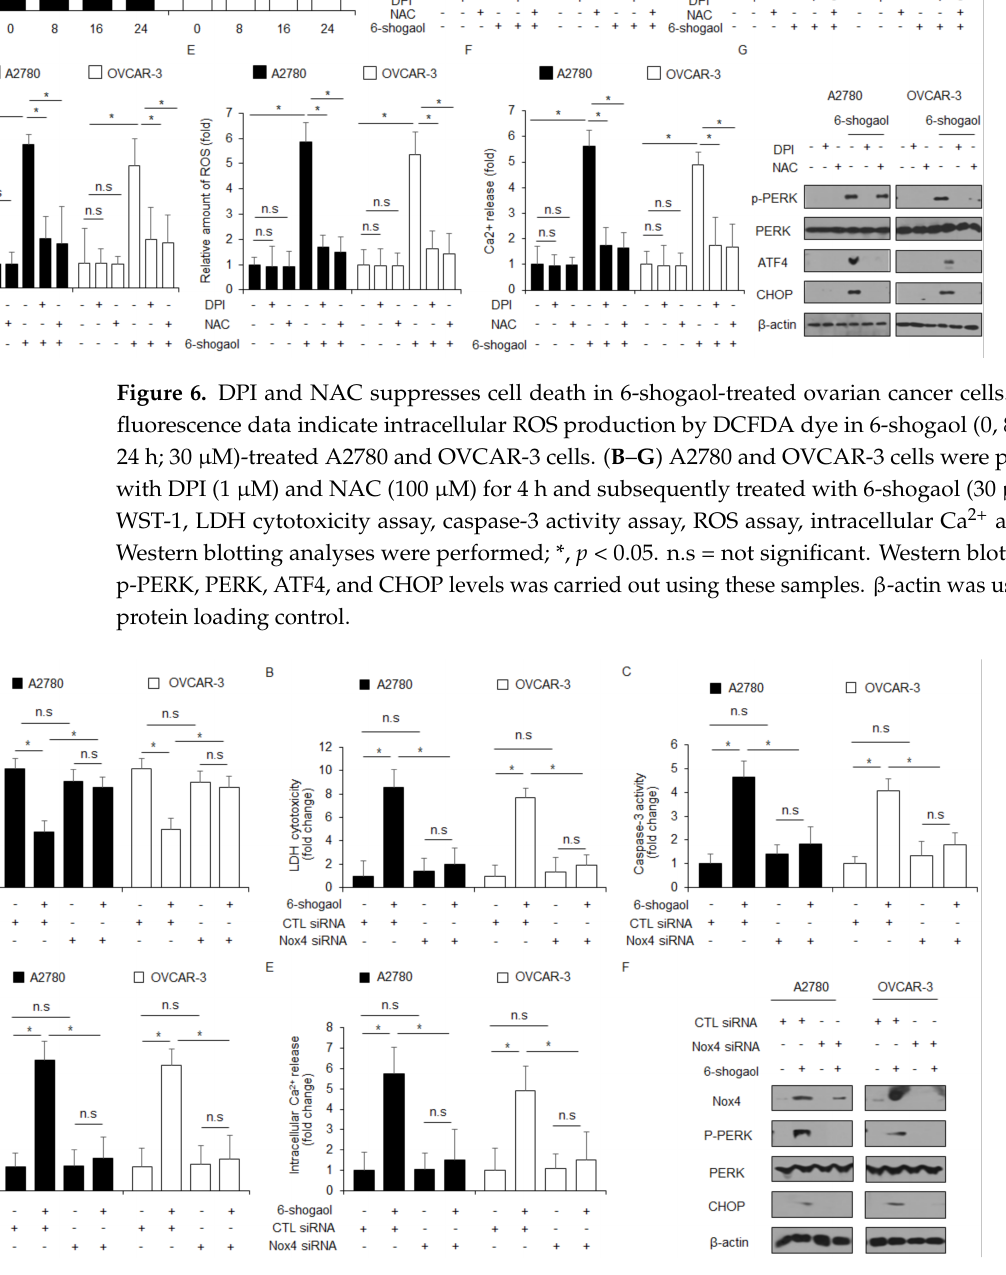
Figure 7. Nox4 regulates cell death and ER stress response in 6-shogaol-treated ovarian cancer cells. ( A – F ) A2780 and OVCAR-3 cells were transfected with Nox4 siRNAs and treated with 6-shogaol (30 µ M, 24 h). WST-1 assay, LDH cytotoxicity assay, caspase-3 activity assay, intracellular ROS assay, and intracellular Ca 2+ assay was performed along with Western blot analysis for Nox4, p-PERK, PERK, and CHOP; *, p < 0.05. n.s = not significant. β -actin was used as the protein loading